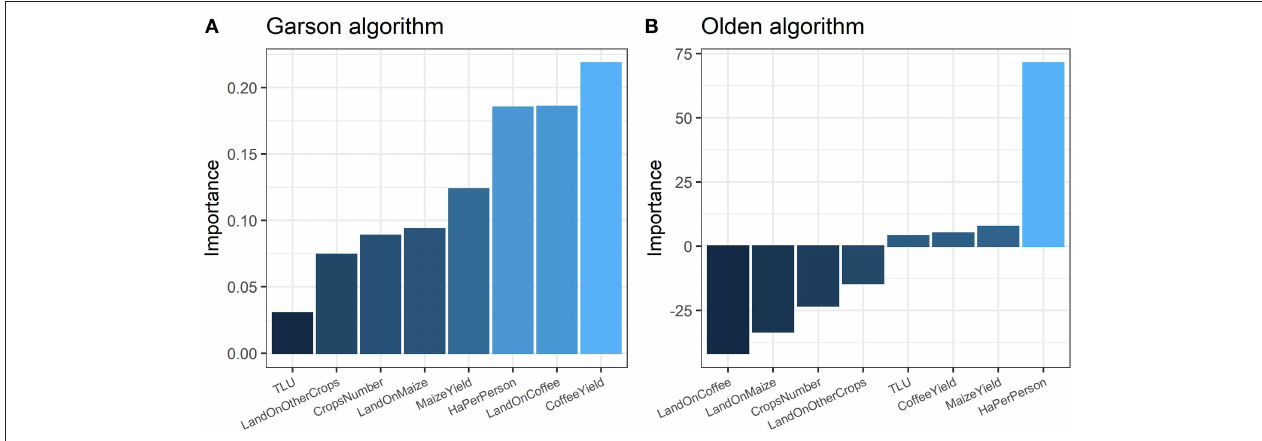
FIGURE 4 | Variable importance for food security prediction in the ANN model according to two different algorithms: (A) the Garson algorithm, which orders variables by their explanatory power, and (B) the Olden algorithm, which orders the variables by their explanatory power and also shows the positive or negative effect on the predicted